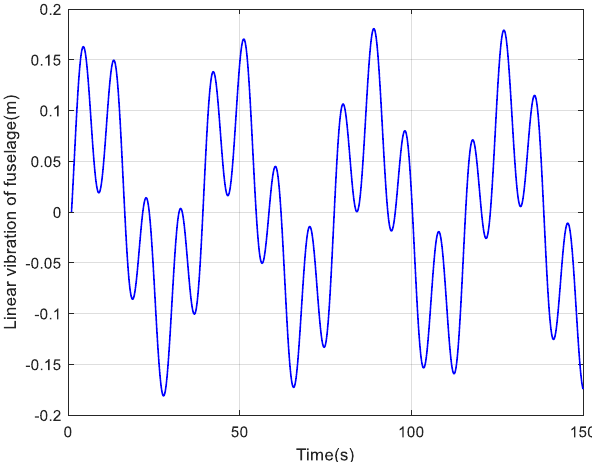
Figure 6. The curve of linear vibration of roadheader fuselage.